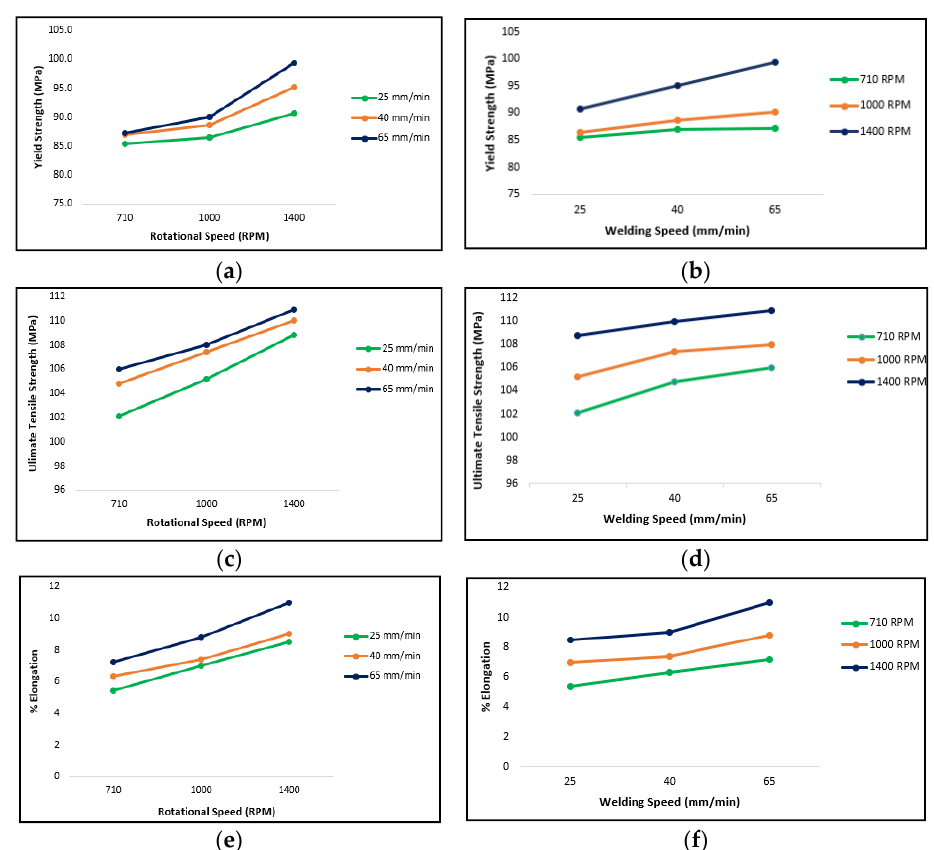
Figure 12. ( a ) Tool RPM Vs. YS, ( b ) Weld Speed Vs. YS, ( c ) Tool RPM Vs. UTS, ( d ) Weld Speed Vs. UTS, ( e ) Tool RPM Vs. % E, and ( f ) Weld Speed Vs. % E. Table 9. Summary on the impact of welding variables on mechanical properties.